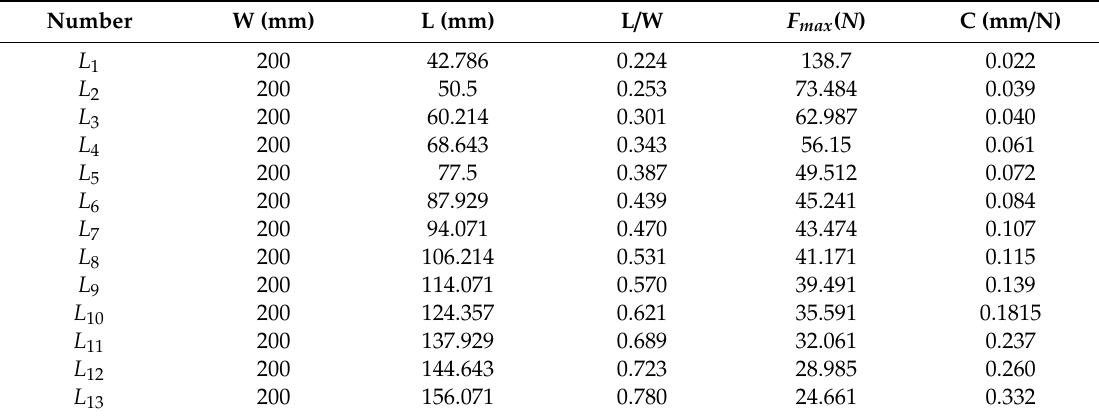
Table 1. Dimensions and test data of the double cantilever beam (DCB (test piece (TL